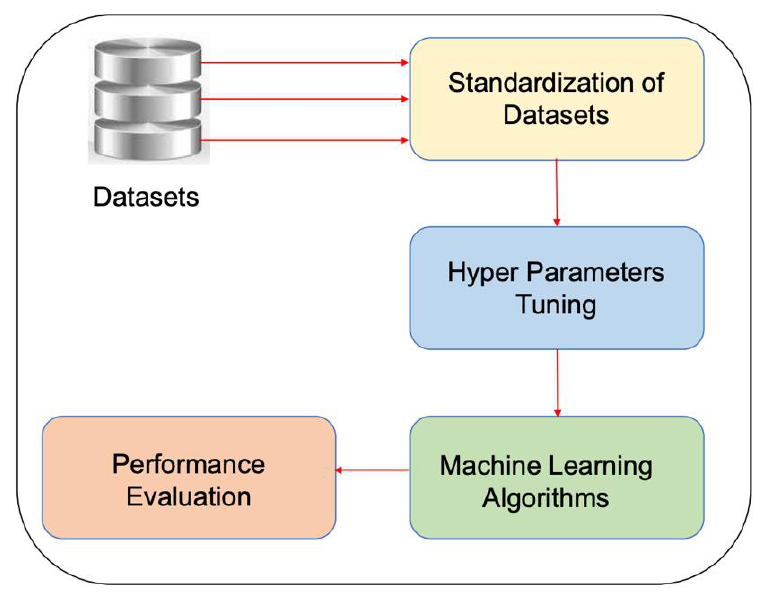
Figure 1. Methodology block diagram.